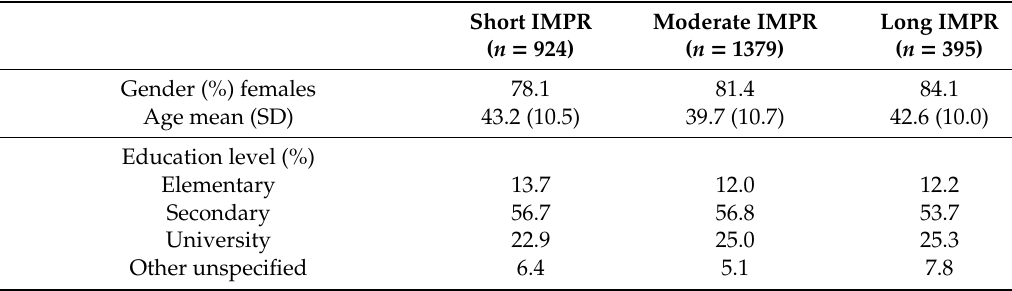
Table 1. Patient baseline characteristics ( n =